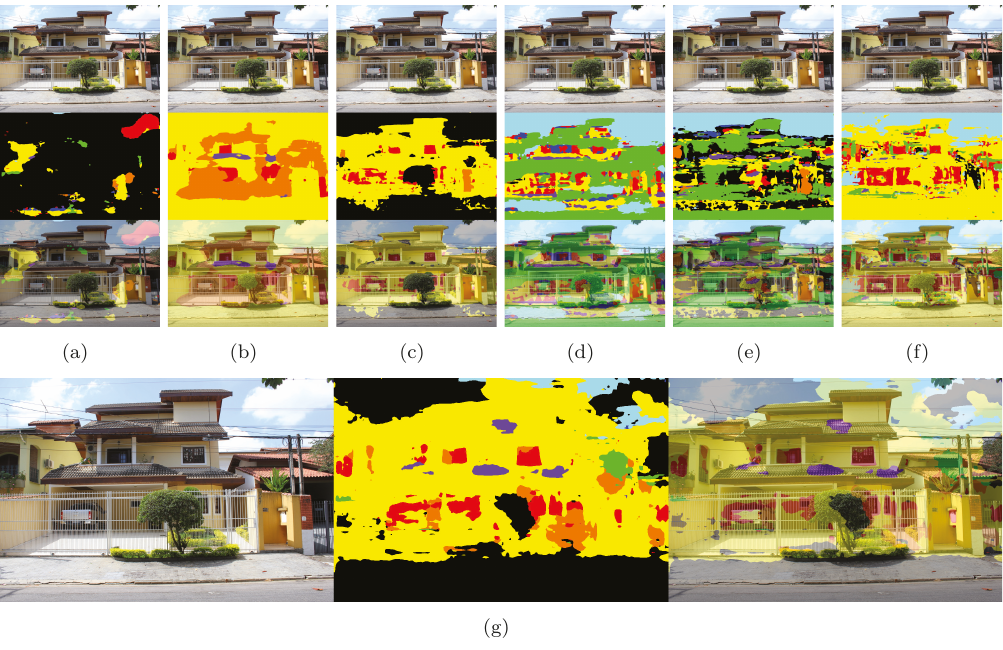
Figure 11. Segmented image from the SJC dataset. Inferences between individual training knowledge. Result using: ( a ) RueMonge2014 knowledge; ( b ) CMP; ( c ) eTRIMS; ( d ) ECP; ( e ) ENPC; ( f ); and Graz; ( g ) result using all